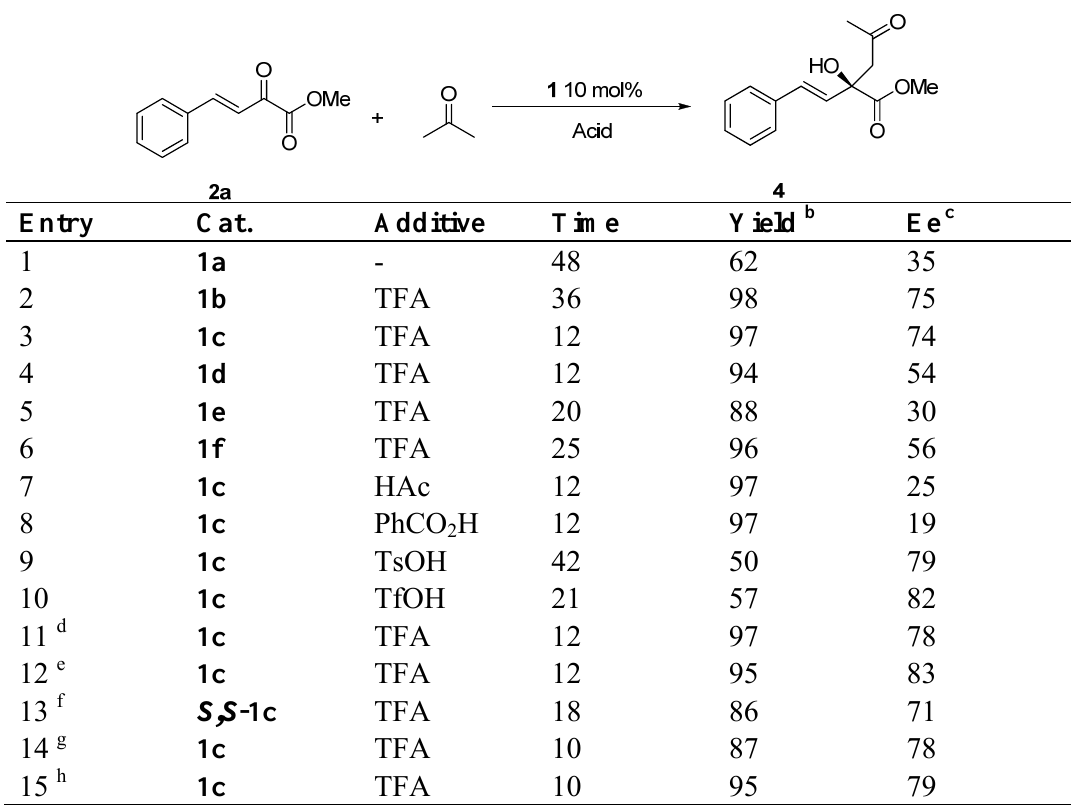
Table 1. The reaction between α,β -unsaturated keto ester and acetone.